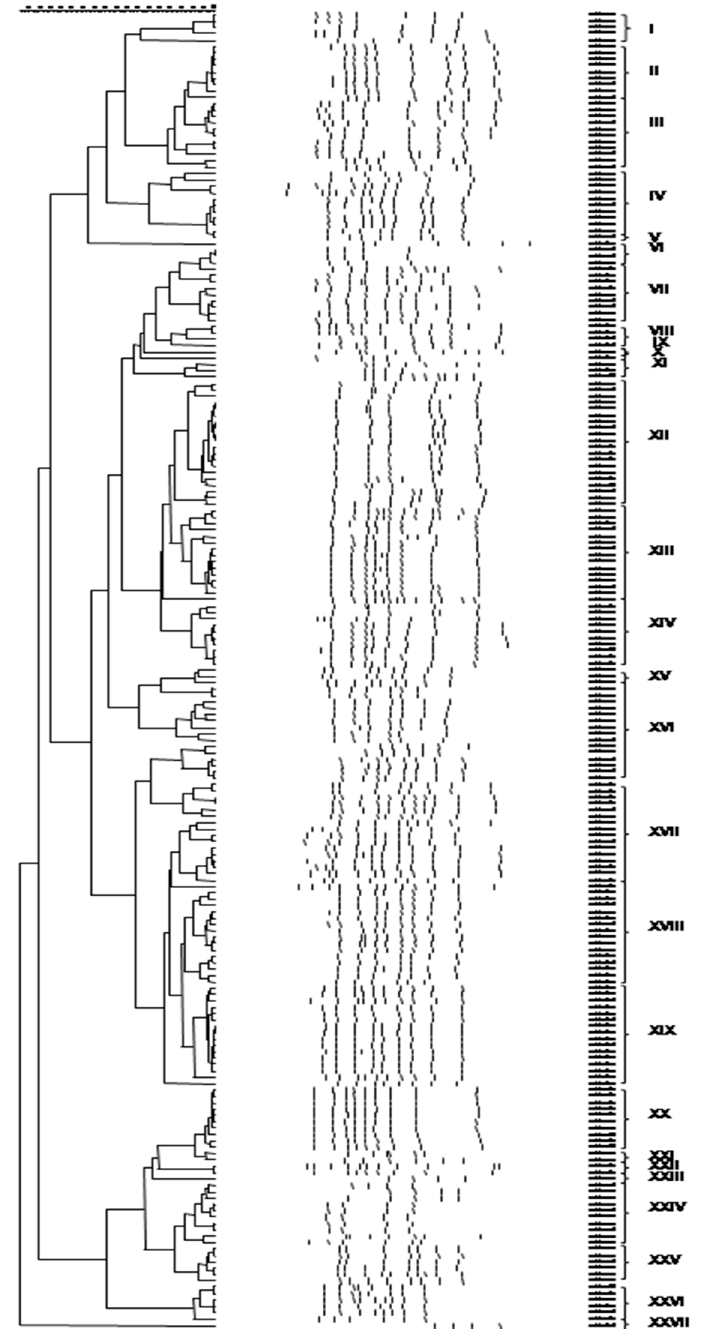
Figure 2. Cluster analysis of PCR-RAPD patterns of bacterial isolates, obtained from 13 Greek wheat sourdoughs. Distance is indicated by the mean correlation coefficient [r (%)] and clustering was performed by UPGMA analysis. The representative strains selected for 16S rRNA gene sequencing are underlined. Latin numerals designate bacterial species (I, II, III, VIII, XXIII and XXVII: Cb. paralimentarius , IV, VI, VII, XII, XIII and XIV: Lb. plantarum , V: Ln. citreum , IX: Lb. zymae , X: Ln. mesenteroides , XI: Lc. lactis , XV, XVI, XVII, XVIII, XIX and XXV: Lb. brevis , XX and XXII: Lb. sakei , XXI and XXIV: Fb. sanfranciscensis , XXVI: Lb. curvatus ).